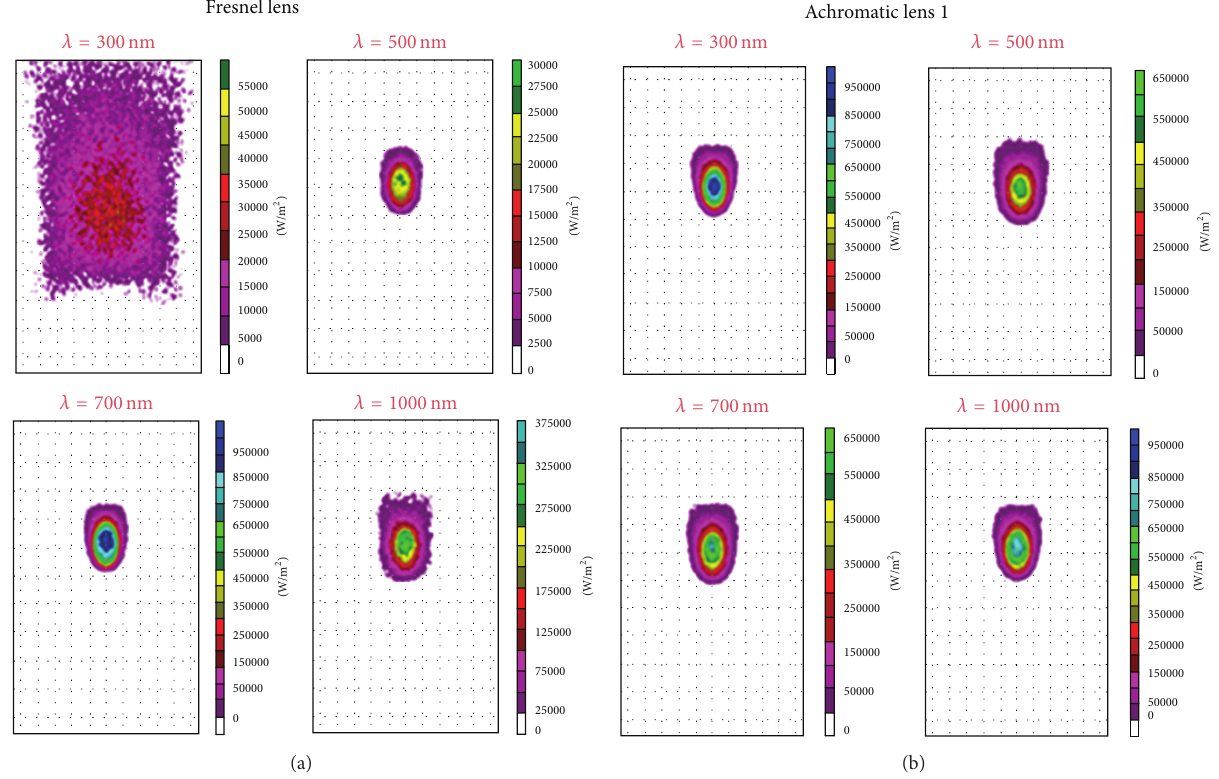
Figure 6: Irradiance maps on entry surface of secondary optics. Fresnel versus achromatic lens 1.